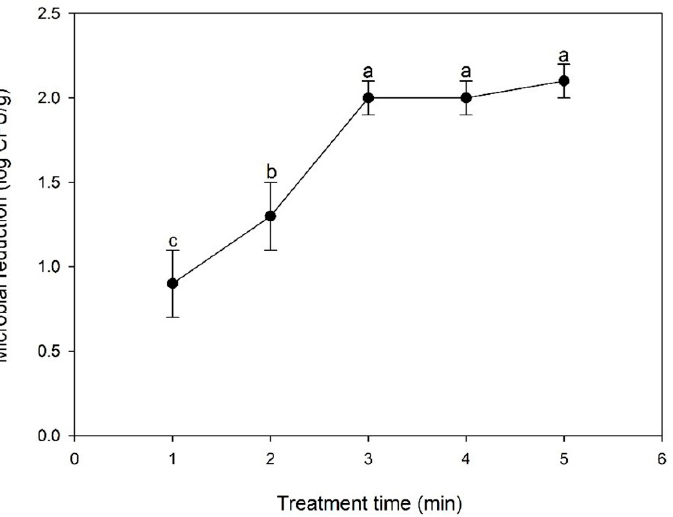
Figure 3. Effects of the in-package cold plasma treatment time on the inactivation of indigenous aerobic mesophilic bacteria in Korean rice cakes. The letters above the error bars indicate a significant difference ( p < 0.05) between the test groups ( n = 6).